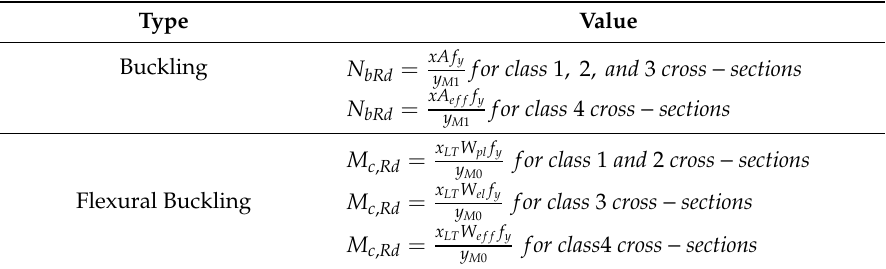
Table 6. Buckling resistance of members.